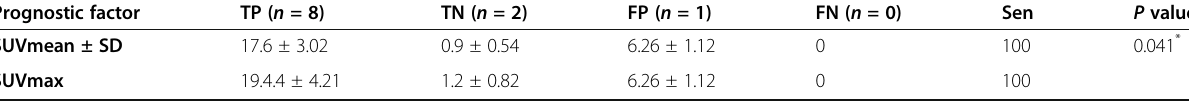
Table 5 The diagnostic value of SUVmean and SUVmax in 11 patients of suspicion of recurrent locoregional disease Prognostic